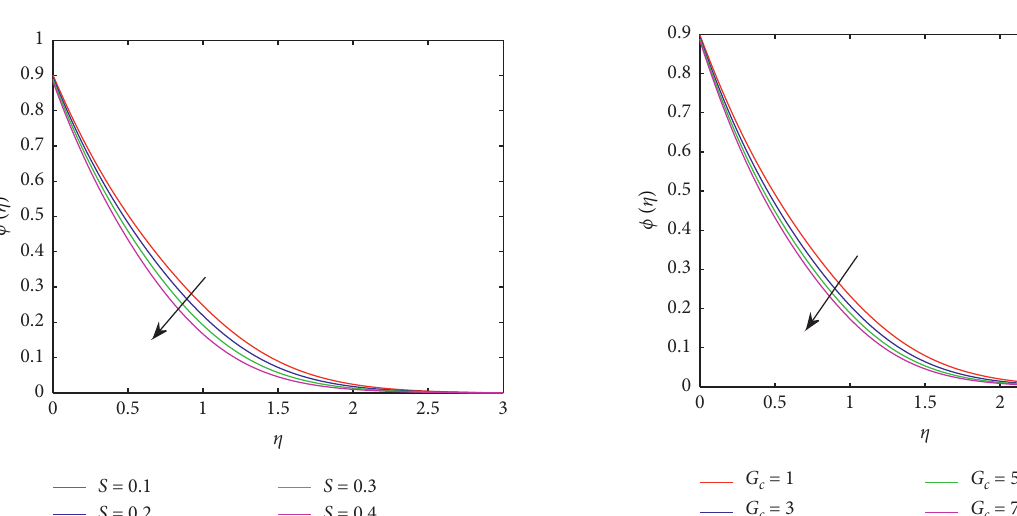
Figure 22: Variation due to G